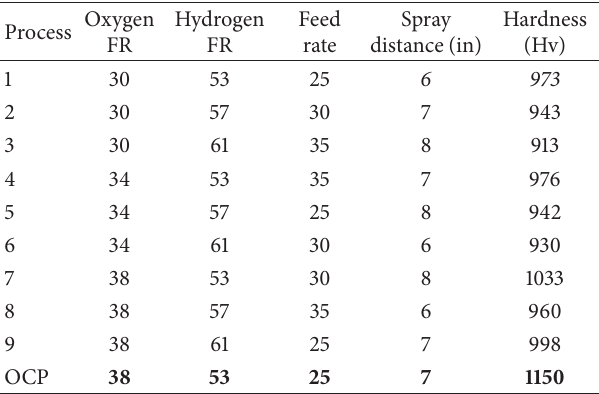
Table 2: Coating processes prepared by Taguchi program and OCP of the highest surface